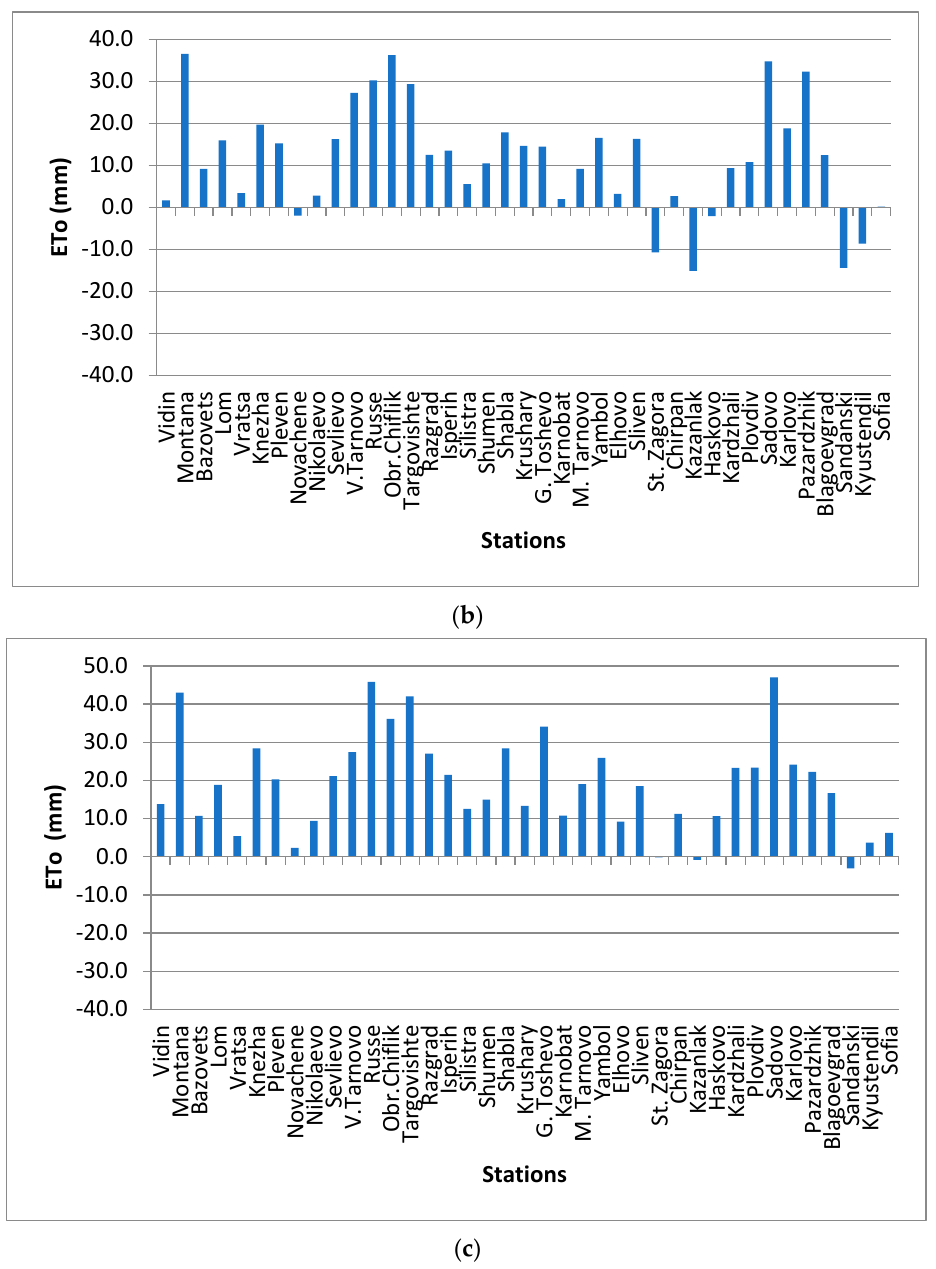
Figure 9. Deviation in the sum of ETo (mm) for the periods: ( a ) March–October; ( b ) April–June; ( c ) July–August. During the second period IV–VI the tendencies in the changes are the same, Figure 9b. The biggest increase in the water deficit was observed during the third period VI–VIII with values between 20–40 mm.